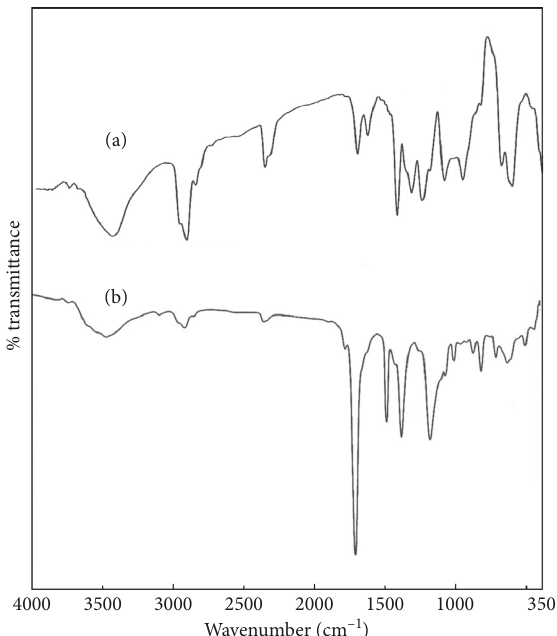
Figure 8: FTIR spectra of PVC stabilized by N -(4-BrPh)IM through (a) chemical modification and (b) graft copolymerization.